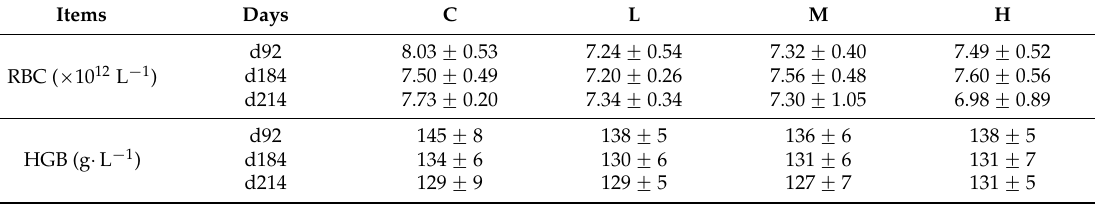
Table 4. Summary of hematology in female rats (